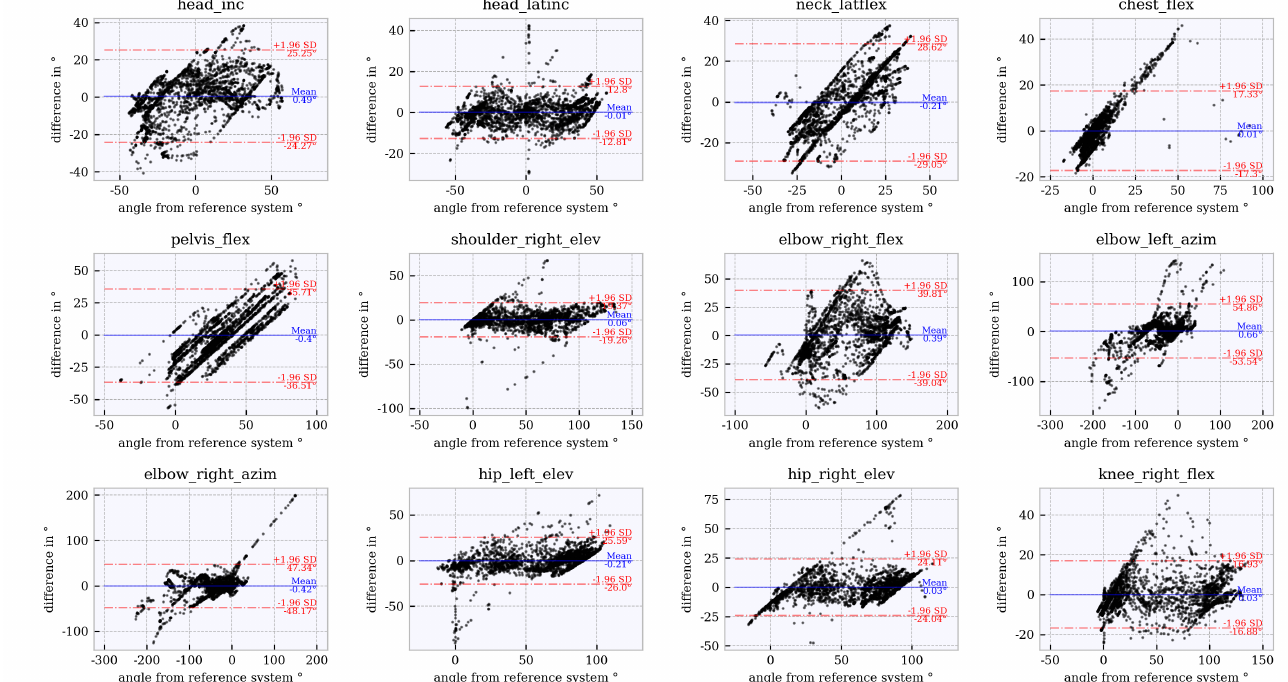
Figure A5. Bland–Altman plot for tracker configuration 9 ; x does not show the average of both systems but the joint angles of the reference system,